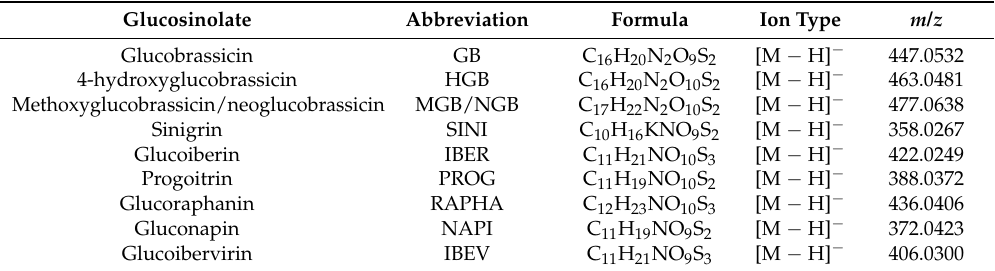
Table 2. GSLs found in Albatros and Target cv.